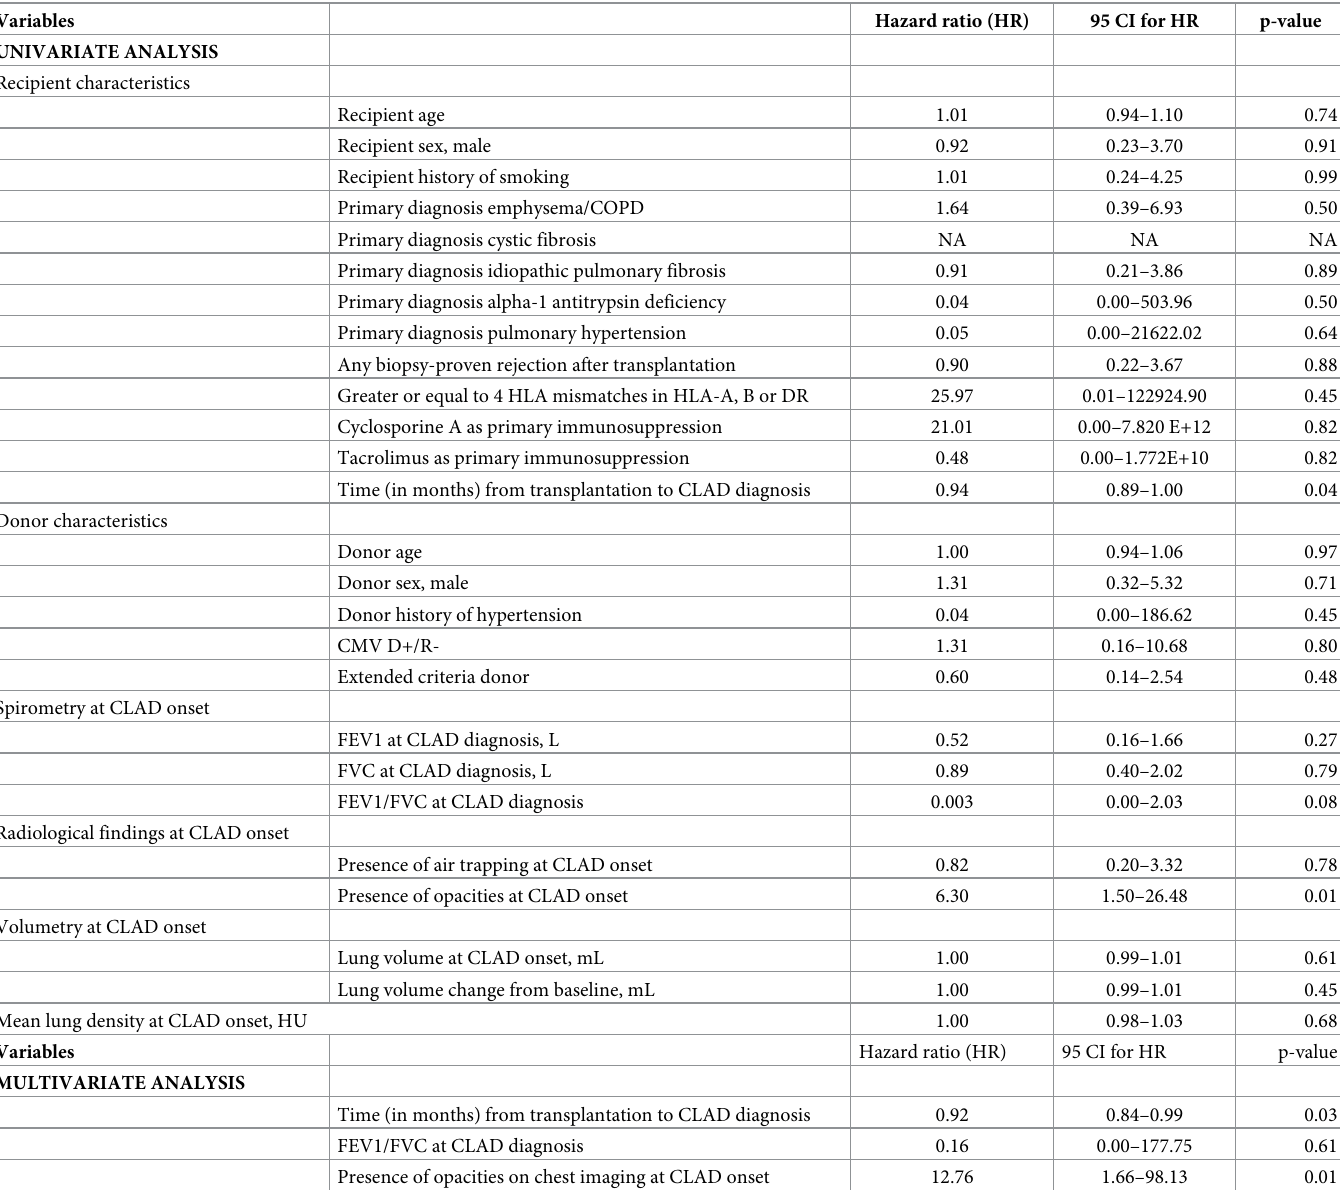
Table 4. a. Cox regression analysis on risk factors for BOS to RAS transition. b. Multivariate Cox regression analysis on risk factors for BOS to RAS transition.